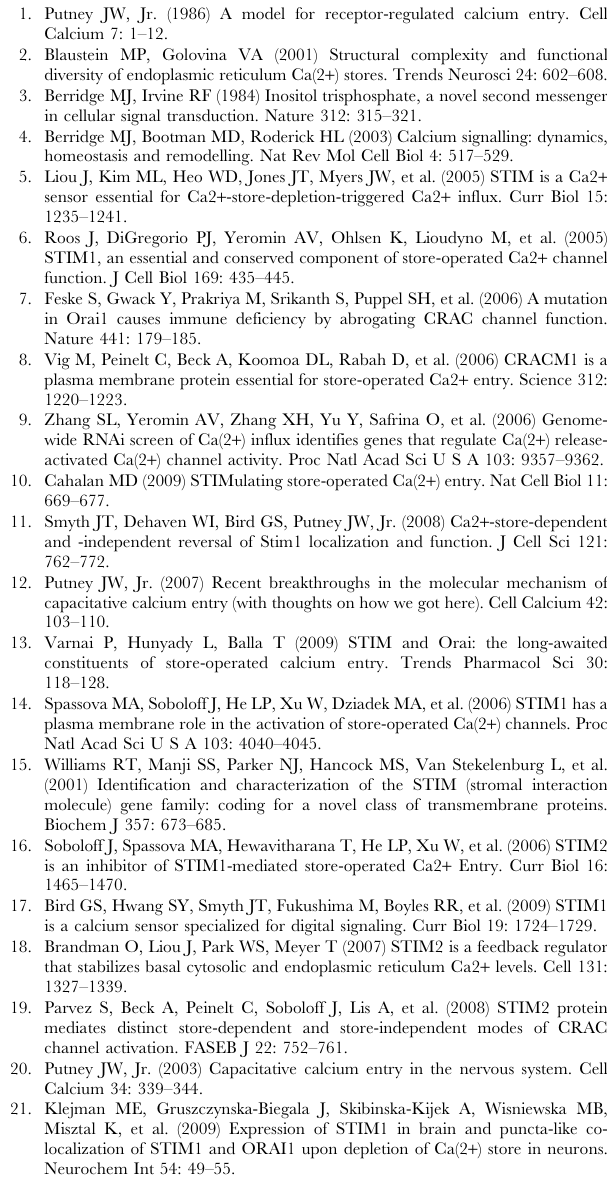
Figure S2 Analysis of constitutive calcium entry in transfected cortical neurons. Cytosolic Ca 2 + measurements were performed in cells overexpressing YFP-STIM1 6 ORAI1 or YFP-STIM2 6 ORAI1 or in nontransfected (NT) cells. The experiments started in the presence of 2 mM CaCl 2 , followed by transfer to Ca 2 + -free medium. A buffer was then supplemented with 2 mM CaCl 2 for 5 min to monitor intracellular Ca 2 + restoration ( A ). Finally, 50 m M 2-APB was added ( B ). The measurements were performed relative to the average [Ca 2 + ] i recorded in Ca 2 + -free medium (200–400 s of experiment) ( A ) or relative to the average [Ca 2 + ] i recorded in Ca 2 + -rich medium ( B ) normalized to 1. Raw traces are shown in Figure